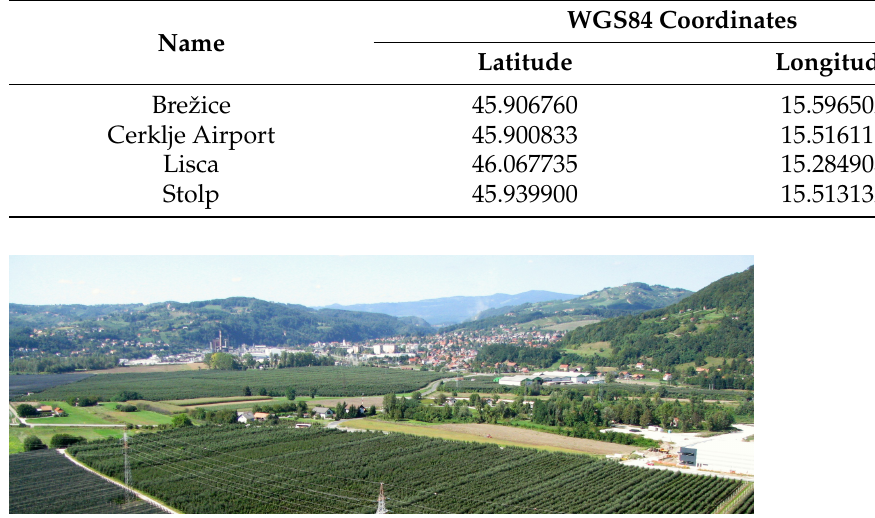
Figure 2. A panoramic view of the study area. Photo by Samo